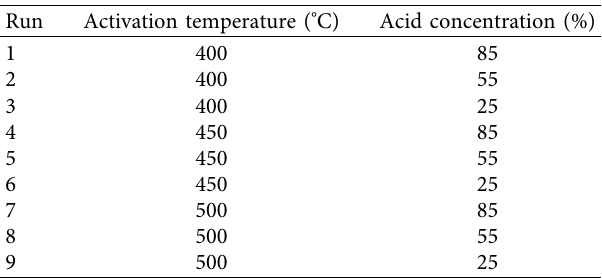
Table 1: Diferent activating temperatures and acid concentrations for the preparation of activated